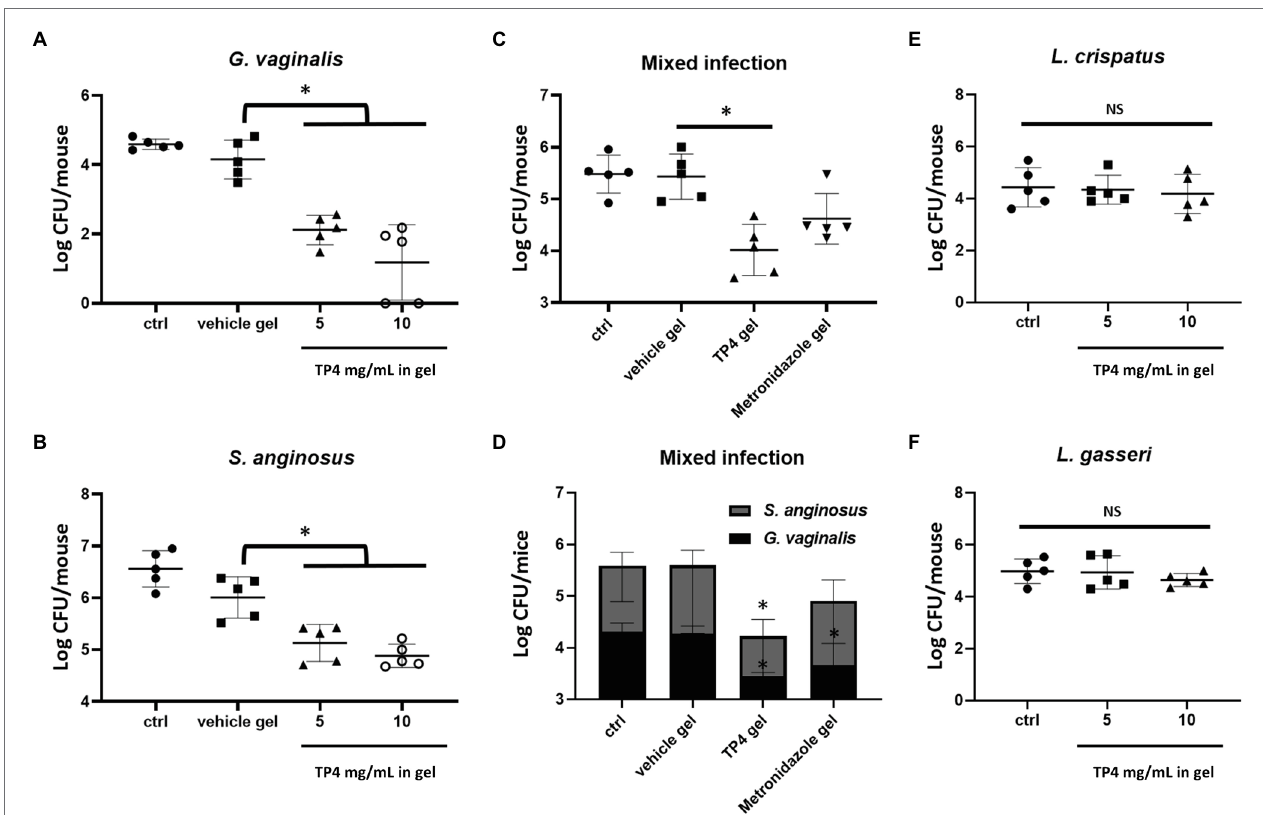
FIGURE 8 | In vivo effects of TP4 microbicide formulation. Eight-week-old female C57BL/6 mice under pseudo-estrus conditions were vaginally treated two times per day with 20 μ l vehicle gel or TP4 at 5 or 10 mg/ml in gel (A,B) , vehicle gel or TP4 or metronidazole (7.5 mg/ml) in gel (C,D) , and TP4 at 5 or 10 mg/ml in gel (E,F) after inoculation with Gardnerella vaginalis (A) , Streptococcus anginosus (B) , Lactobacillus crispatus (E) , Lactobacillus gasseri (F) or combined G. vaginalis and S. anginosus (C,D) . The results show the CFUs of G. vaginalis and S. anginosus . Vehicle gel contained 0.1% chitosan and 0.4 mM disodium EDTA in saline. Bacteria viability was assessed by CFU plate counts from vaginal lavage (150 μ l vaginal lavage per mouse, n = 5 mice per group). All values represent the mean ± SD. * p < 0.05 compared to vehicle gel (A–D) or ctrl (E,F) , determined by one-way